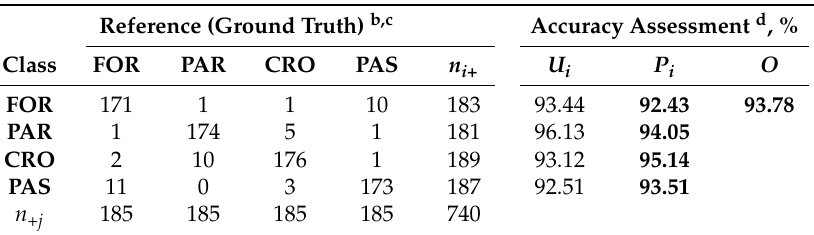
Table 5. The error matrix showing the overall RFC performance expressed in pixel counts, n ij a